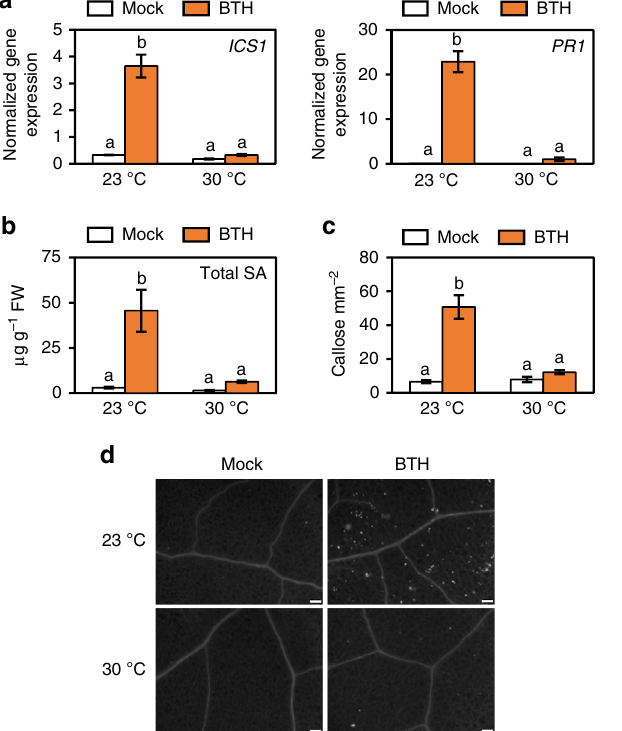
Fig. 3 Induction of SA defence responses is compromised at 30 °C. a SA BTH. b SA metabolite quanti fi cation in plants ( n = 4) 48 h after spraying